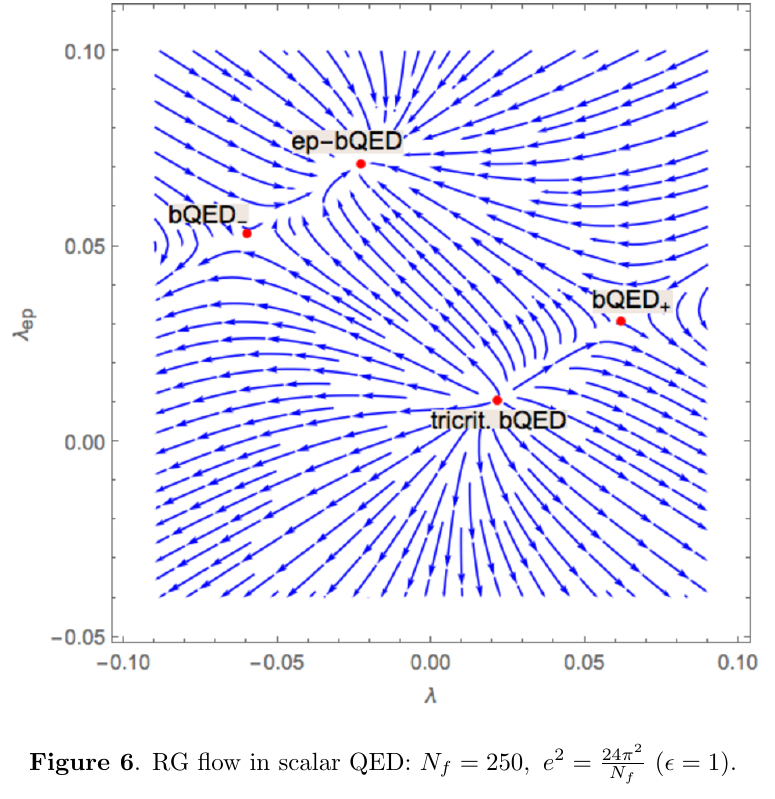
Figure 6 . RG (cid:13)ow in scalar QED: N f = 250 ; e 2 = 24 (cid:25) 2